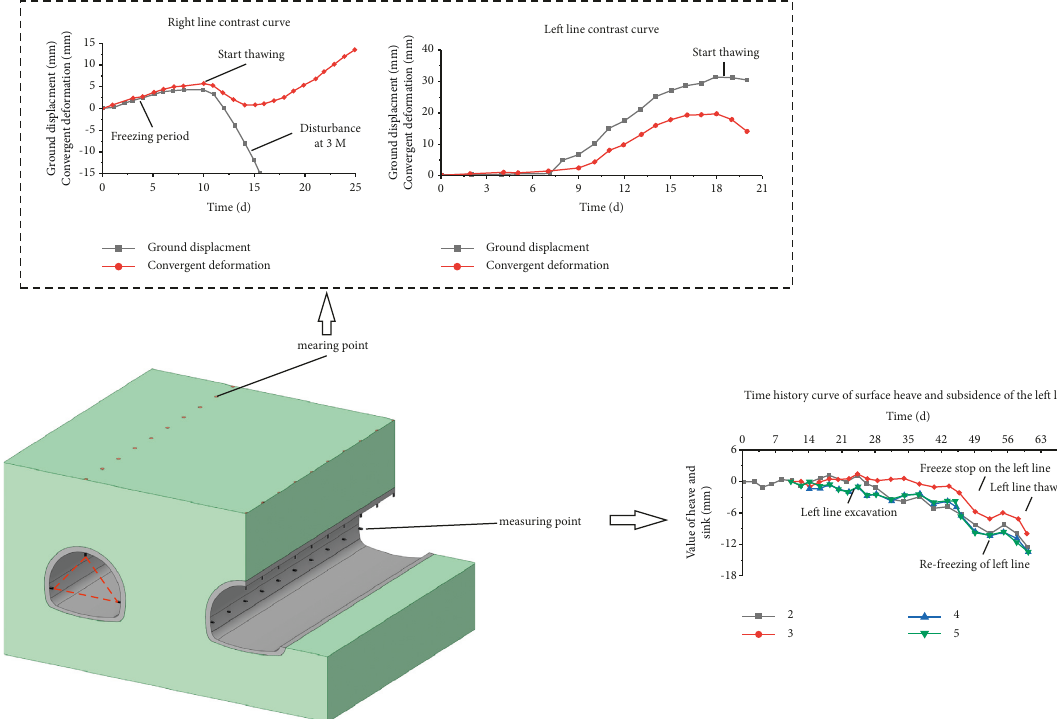
Figure 15: Tunnel ground displacement, convergence deformation, and surface heave and subsidence